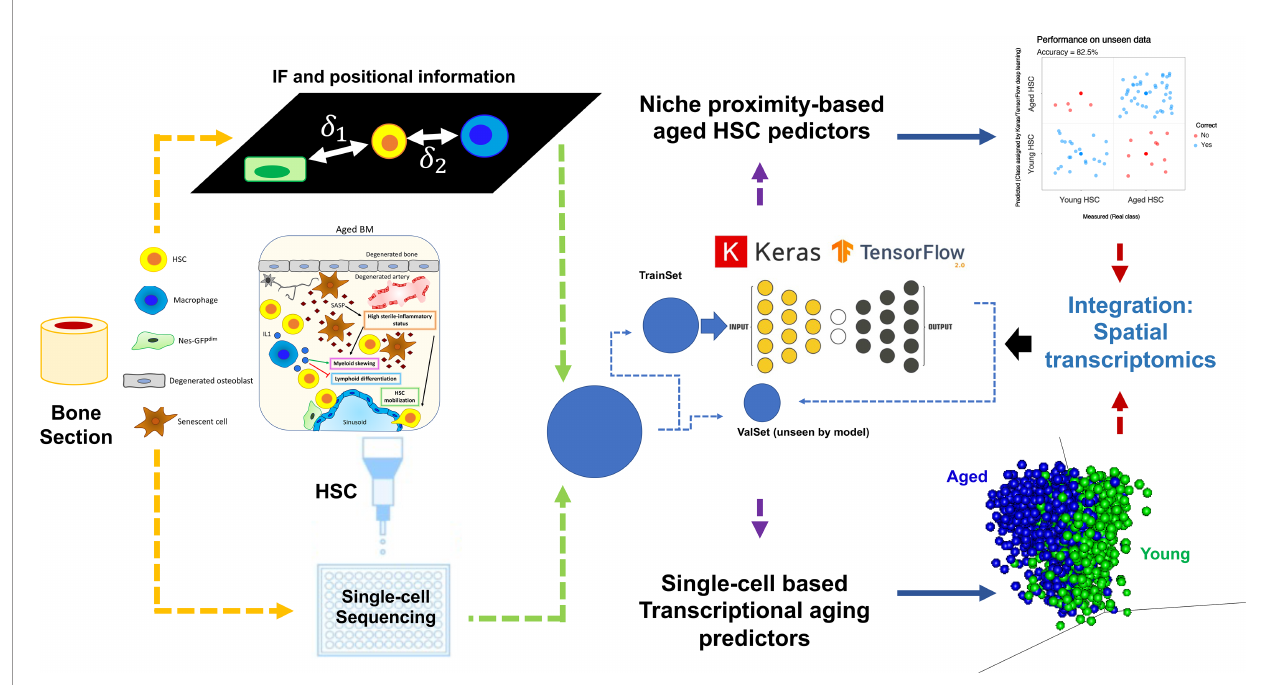
FIGURE 5 | Implementation of deep learning, by integrating various datasets, to elucidate the impact of aging-mediated niche dynamics on HSC positioning and function. Here are shown two types of datasets: 1) upper part: immuno fl uorescence positional information showing the relative distance of HSC to niche cells and 2) lower part: single-cell sequencing of sorted HSCs. Due to the adaptability and fl exibility of deep learning methodologies, both datasets are analyzed using, for instance, an R implementation of Keras/TensorFlow (165). Models are trained using a subset of the data (TrainSet) and different kernel initializations and varying numbers of hidden layers, depending on the dataset at hand. After validation of the model using a subset of data not included in the training (ValSet), prediction accuracies are calculated. For the positional information, we assess if we can predict whether a given cell is young or aged HSC purely based on their relative proximity/distance to a given niche cell and each other. As shown in our recent study (40), using such an approach, we could show ~83% prediction accuracy in de fi ning the age status of HSCs using positional information. Using single-cell dataset and deep learning, we have also recently developed an aging signature with very high prediction accuracy (>95%; unpublished data), where the top predictors could show clear segregation of young and aged cells using principal component analysis (PCA; lower right part of the fi gure). We propose here that by integrating spatial transcriptomics of speci fi c regions of a bone section (including HSCs and niche cells) and deep learning, one can perform an integrated analysis that will not only show transcriptional signatures of the cells assayed but also shed light on how the HSC-niche cell proximity and transcriptional dynamics change upon